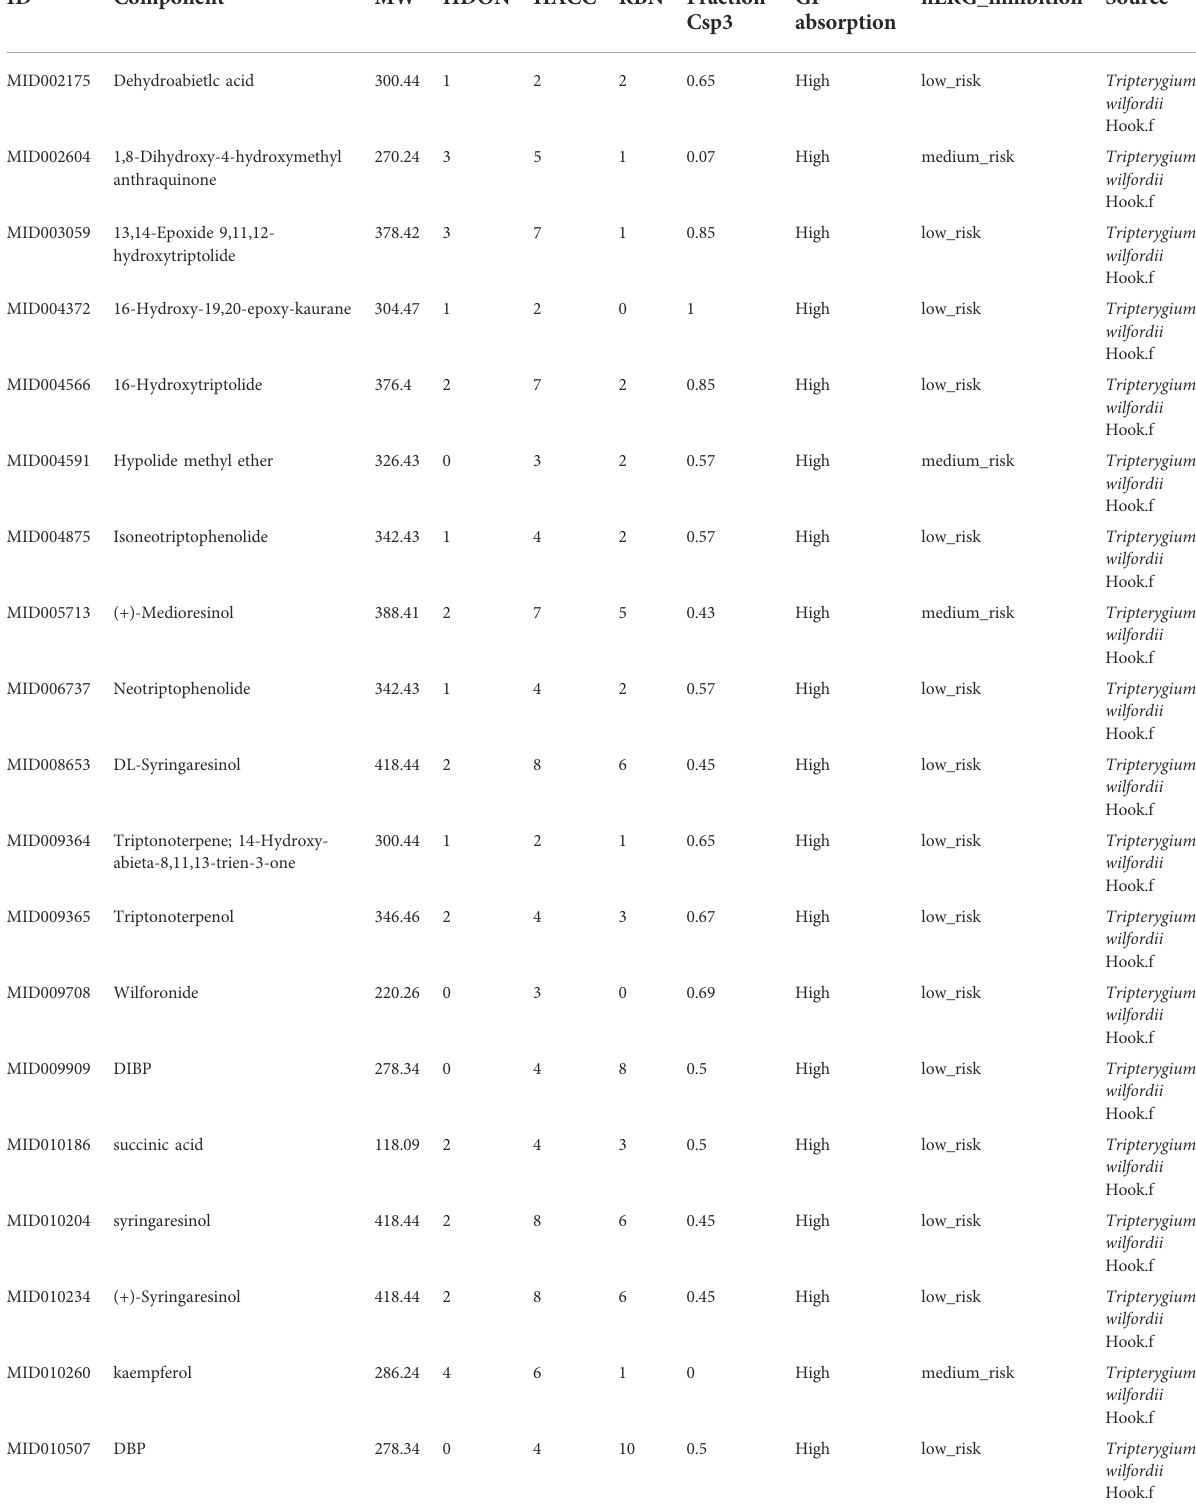
TABLE 2 Components in LGT and JQC for further analysis after screening by